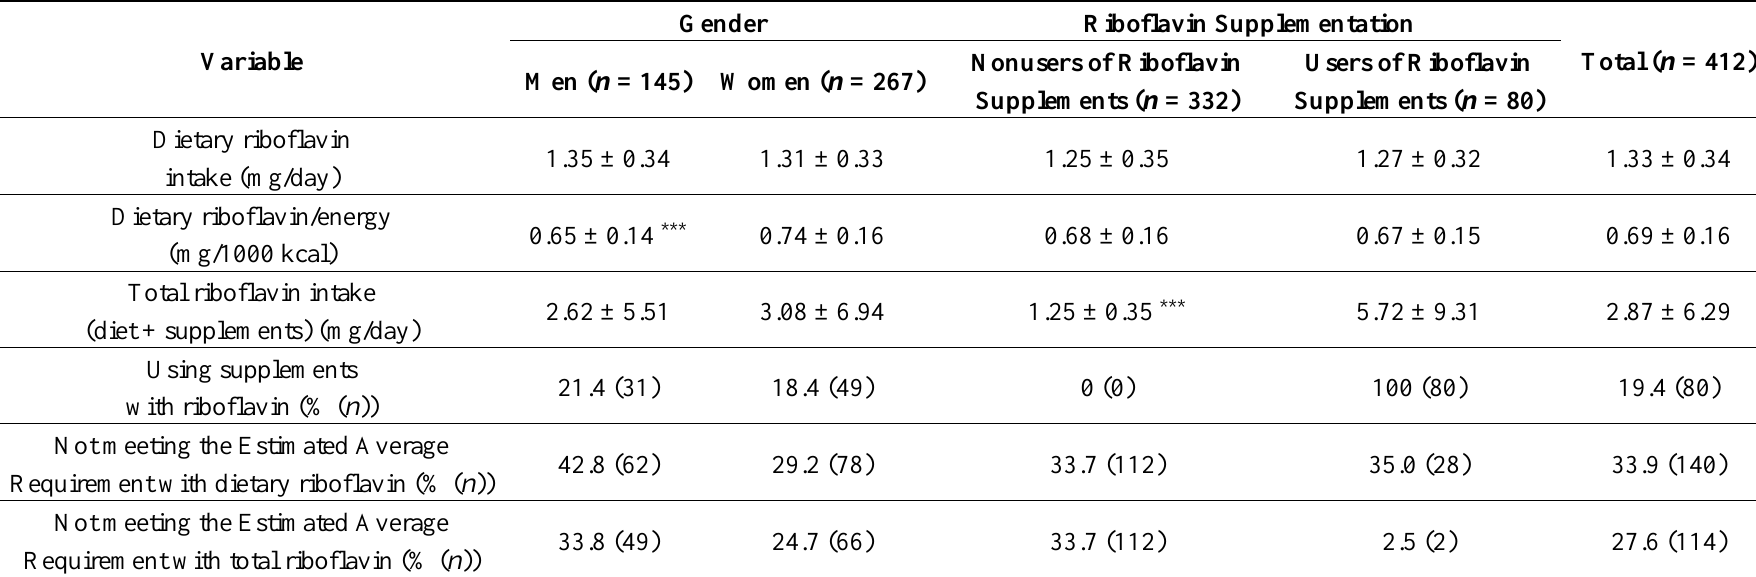
Table 2. Riboflavin intakes of 412 Korean adults by gender and by riboflavin supplementation.